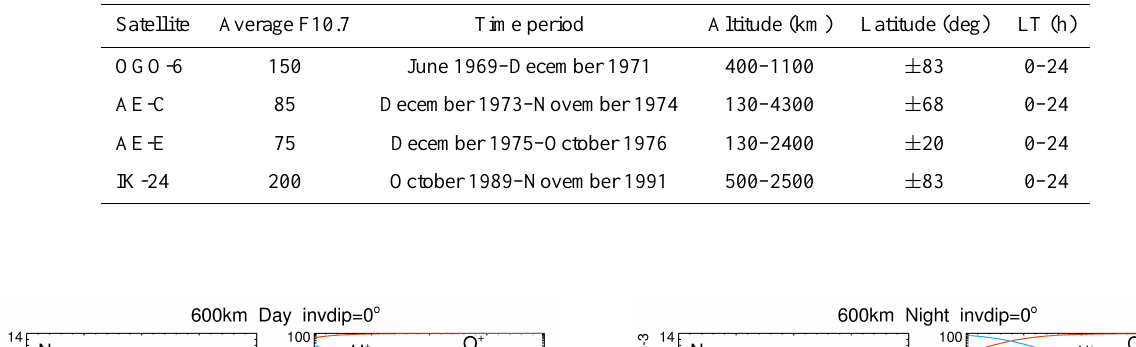
Table 1. Characteristics of the data used.